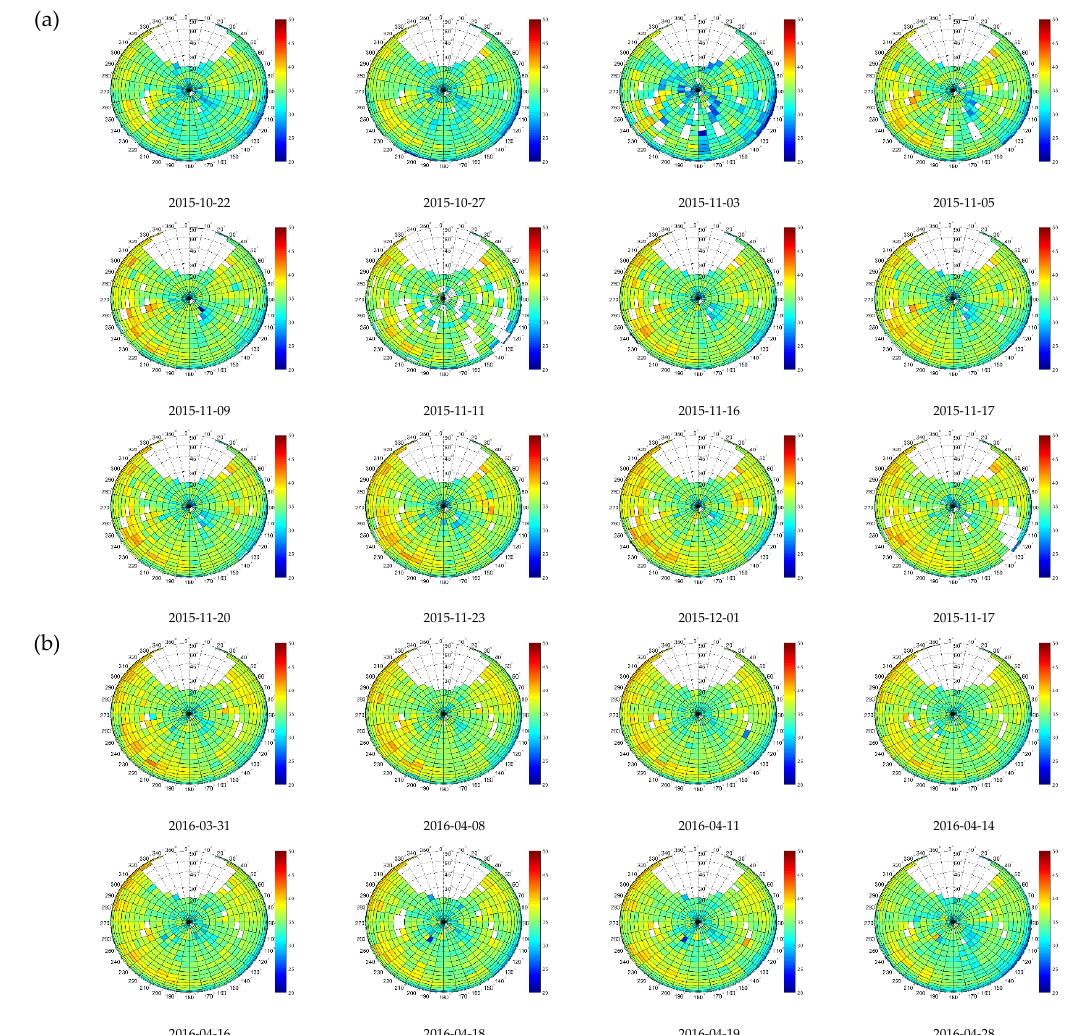
Figure 7. LHCP received C/N 0 during ( a ) the fall and ( b ) the spring season for different dates when vegetation pictures were taken. Incidence angle in 5 ◦ steps, azimuth angle in 10 ◦ steps.